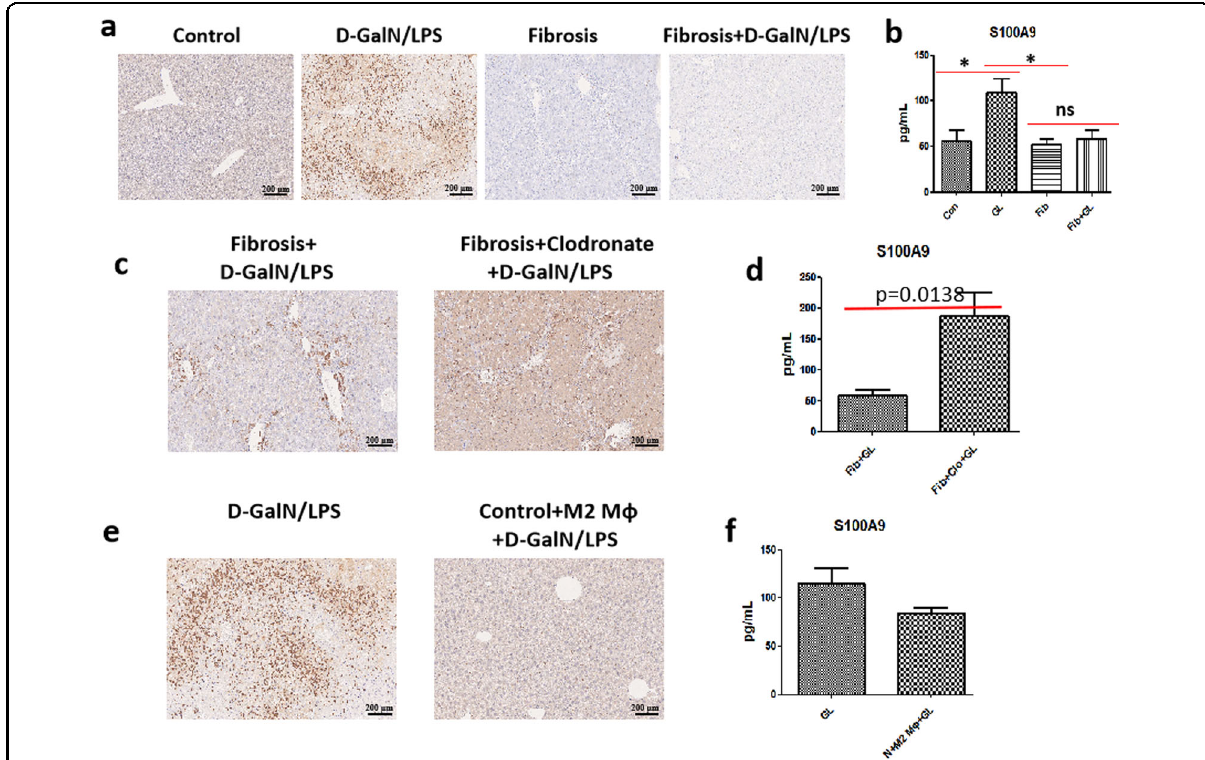
Fig. 4 Fibrosis inhibits S100A9 expression, which can be ascribed to M2-like macrophages. a , b The expression of S100A9 in the livers of control and fi brotic mice with or without D-GalN/LPS challenge. ( n = 4 – 7) c , d Comparison of S100A9 expression in fi brotic mice upon acute insult with or without M2-like macrophage depletion. ( n = 4 – 7) e , f Comparison of S100A9 expression in control mice upon acute insult with or